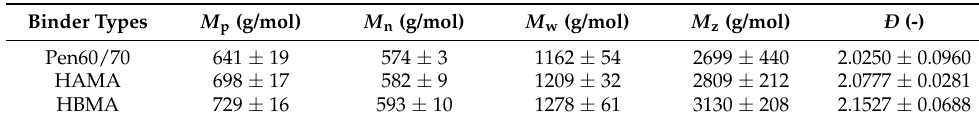
Table 4. Molecular weight distribution.